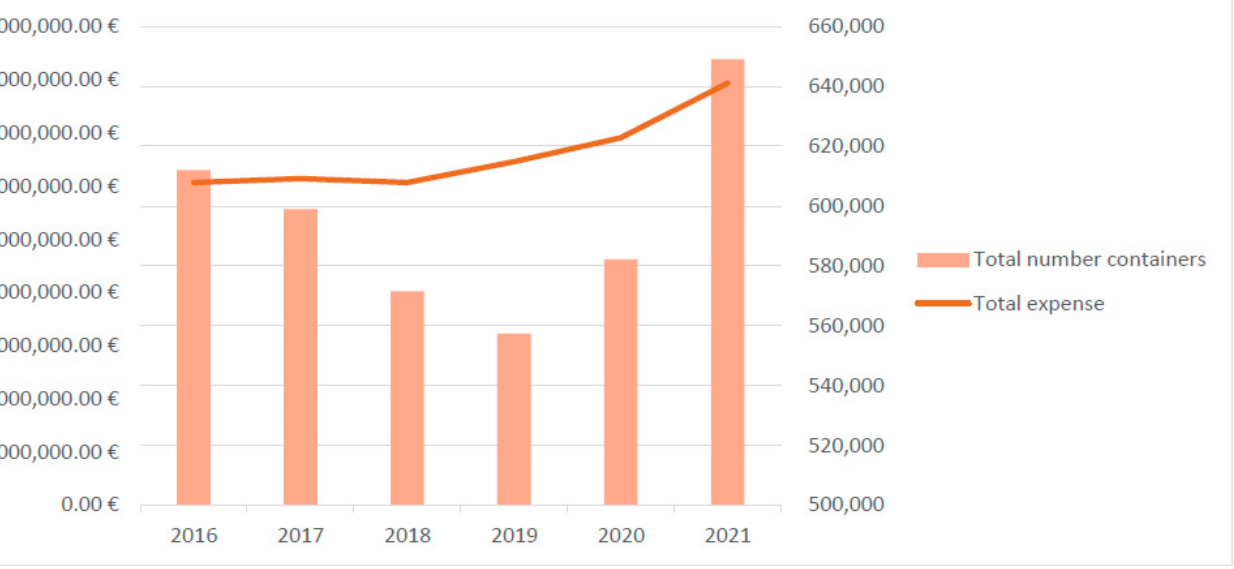
Figure 2. Number of total containers consumed and total expenditure from January 2016 to December 2021 in the Community of Madrid.